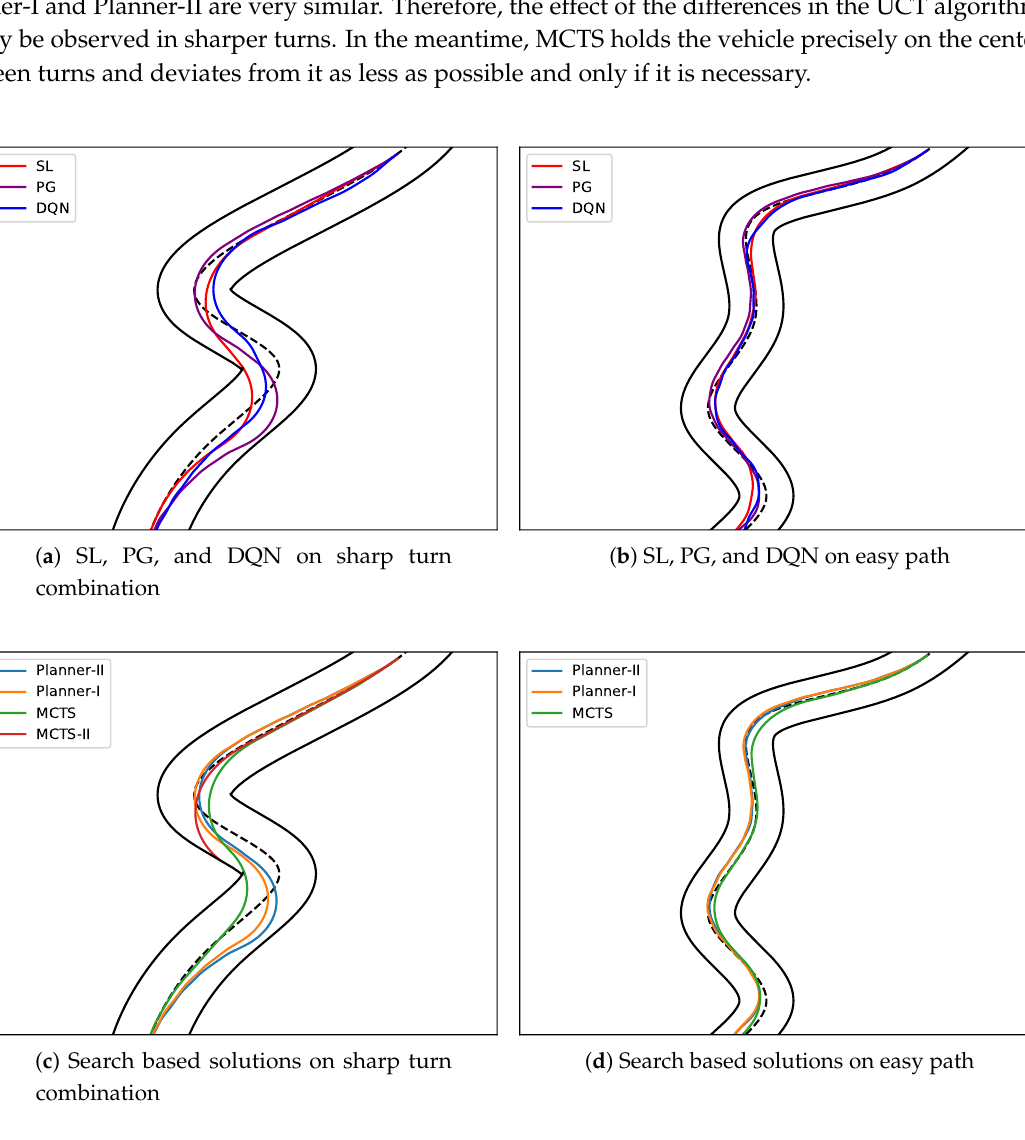
Figure 9. Strategical comparison of the algorithms on various trajectory